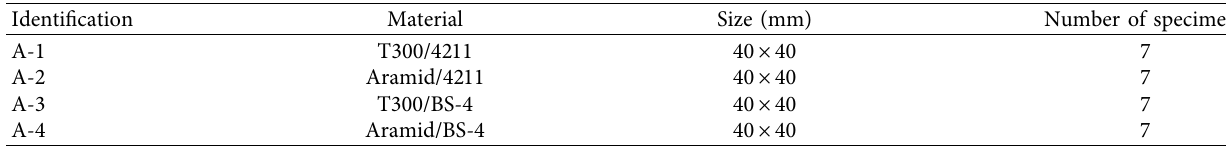
Table 3: Size and identity of composites tested.